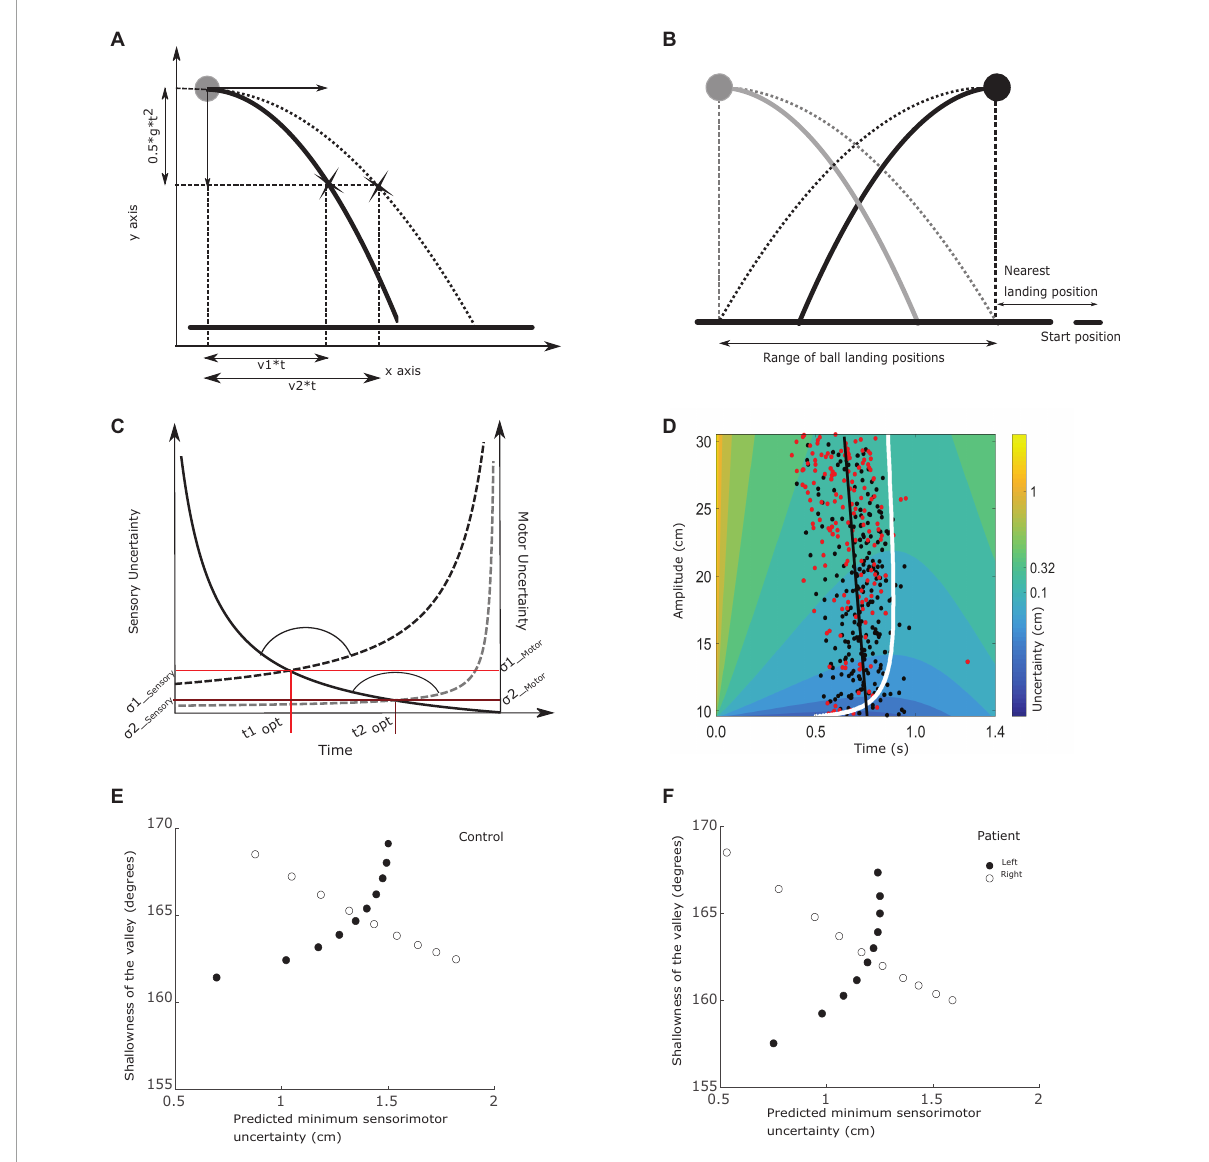
FIGURE2 Relations between outcome measures. (A) Trajectory uncertainty. The ball is projected with a horizontal velocity v1 (between 0 and 15 cm/s) and no initial vertical velocity. The vertical acceleration is set to 25 cm/s 2 . After t seconds, the ball will have traveled v1*t cm horizontally and 0.5*g*t2 vertically. Since the starting height is fixed, the ball always reaches ground level after 1.4 s. Subjects can only move the paddle horizontally at ground level and need to estimate where the ball will hit the ground based on sensory information about the ball trajectory. Sensory uncertainty, at-least in this design, depends on the initial horizontal velocity of the ball; with increasing velocity sensory uncertainty increases. (B) Starting positions. The ball could start from two positions, 20 cm apart, whereas the hand always started moving from the bottom right corner. The horizontal black line represents the ground level. The closest landing position was 9 cm from the hand starting position and was associated with 0 cm/s or 15 cm/s horizontal velocity. In the figure, we obscured a portion of the trajectories to give an indication of the uncertainty of the final landing position with limited viewing duration of the trajectory. Using two starting positions of the ball, we have pairs of trials that require the same movement amplitude but have different sensory uncertainty due to different horizontal ball velocities (e.g., black ball falling straight down and gray ball being projected with 15 cm/s towards the subject). Similarly, we have trials where the same sensory uncertainty is traded off with two different motor uncertainties coming with different movement amplitudes, as shown in the thick black and gray lines. Here the ball is projected with the same horizontal speed, but due to the different starting positions of the ball requires movements of different amplitude to catch the ball. (C) The tradeoff between sensory and motor uncertainty. Here we illustrate the tradeoff between sensory and motor uncertainties using two trials as examples. Sensory uncertainty is represented by the solid line and two motor uncertainties by the dashed lines. As the trial time progresses, sensory uncertainty decreases as more of the trajectory has been seen by the subject. By contrast, motor uncertainty increases as the trial progresses. Here we show two examples of motor uncertainty curves; the lower one represents amovementofsmallamplitude(e.g.,fortheballfallingalongthegraypathin B